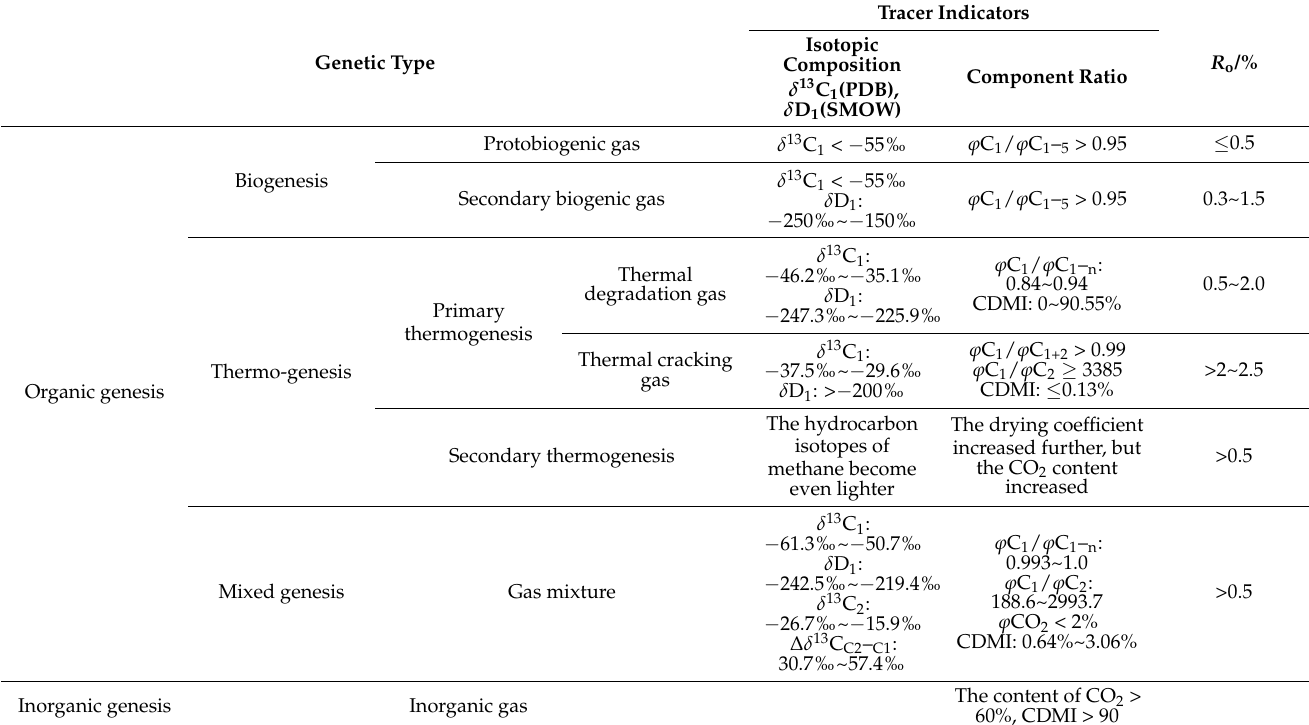
Table 1. Classification of coalbed methane genetic types